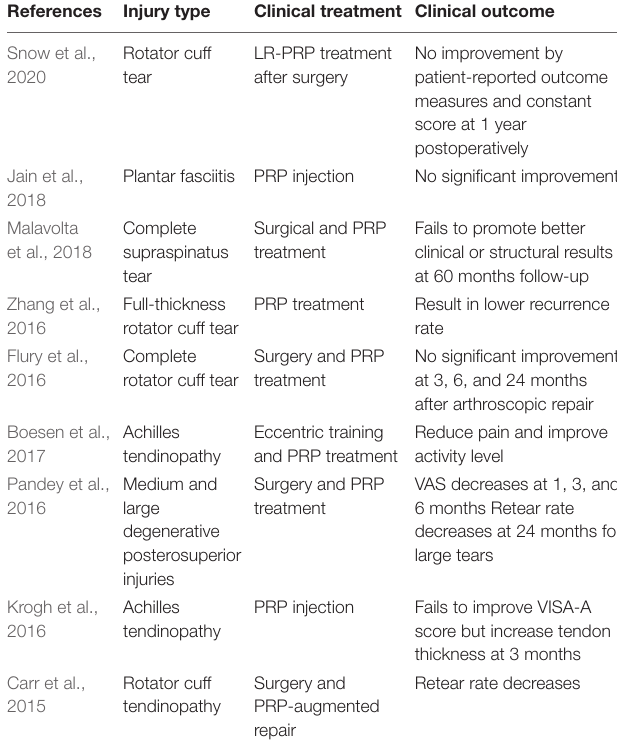
TABLE 1 | Treatment of PRP for rotator cuff injuries and